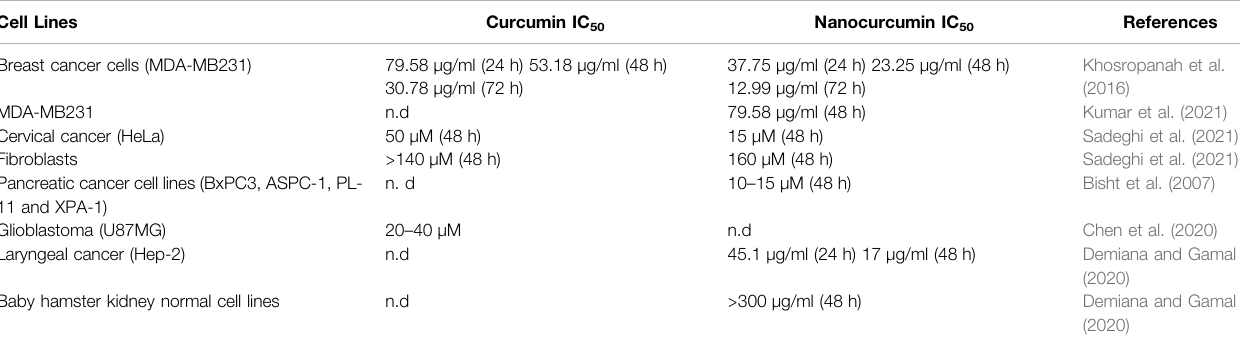
TABLE 1 | Cyototoxicity of curcumin and nanocurcumin a . Cell